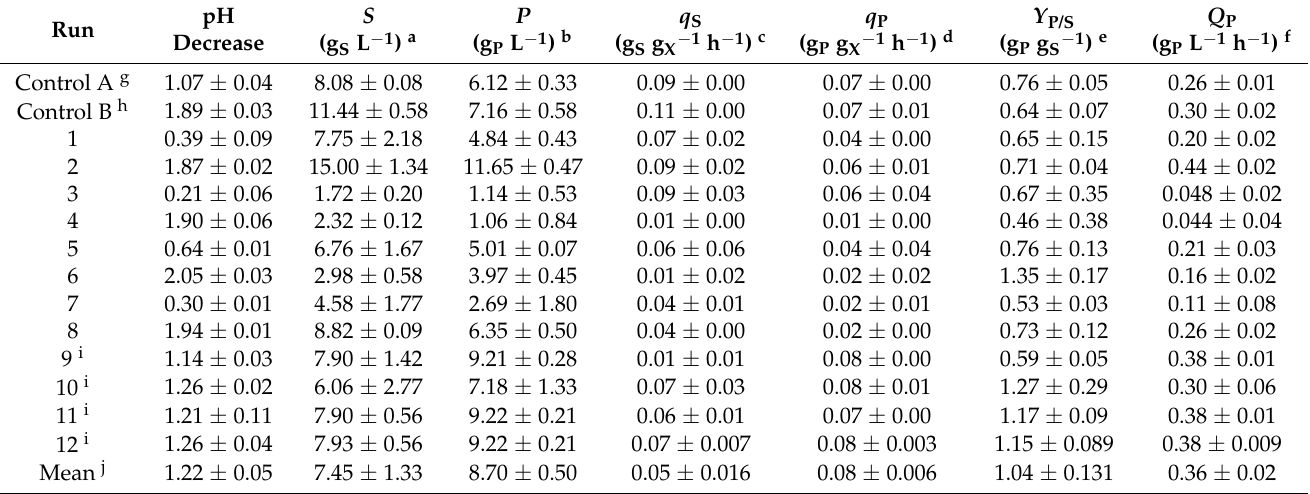
Table 3. Main experimental results of P. pentosaceus ATCC 43200 cultivations related to substrate consumption and lactic acid formation. Values were collected after 24 h of